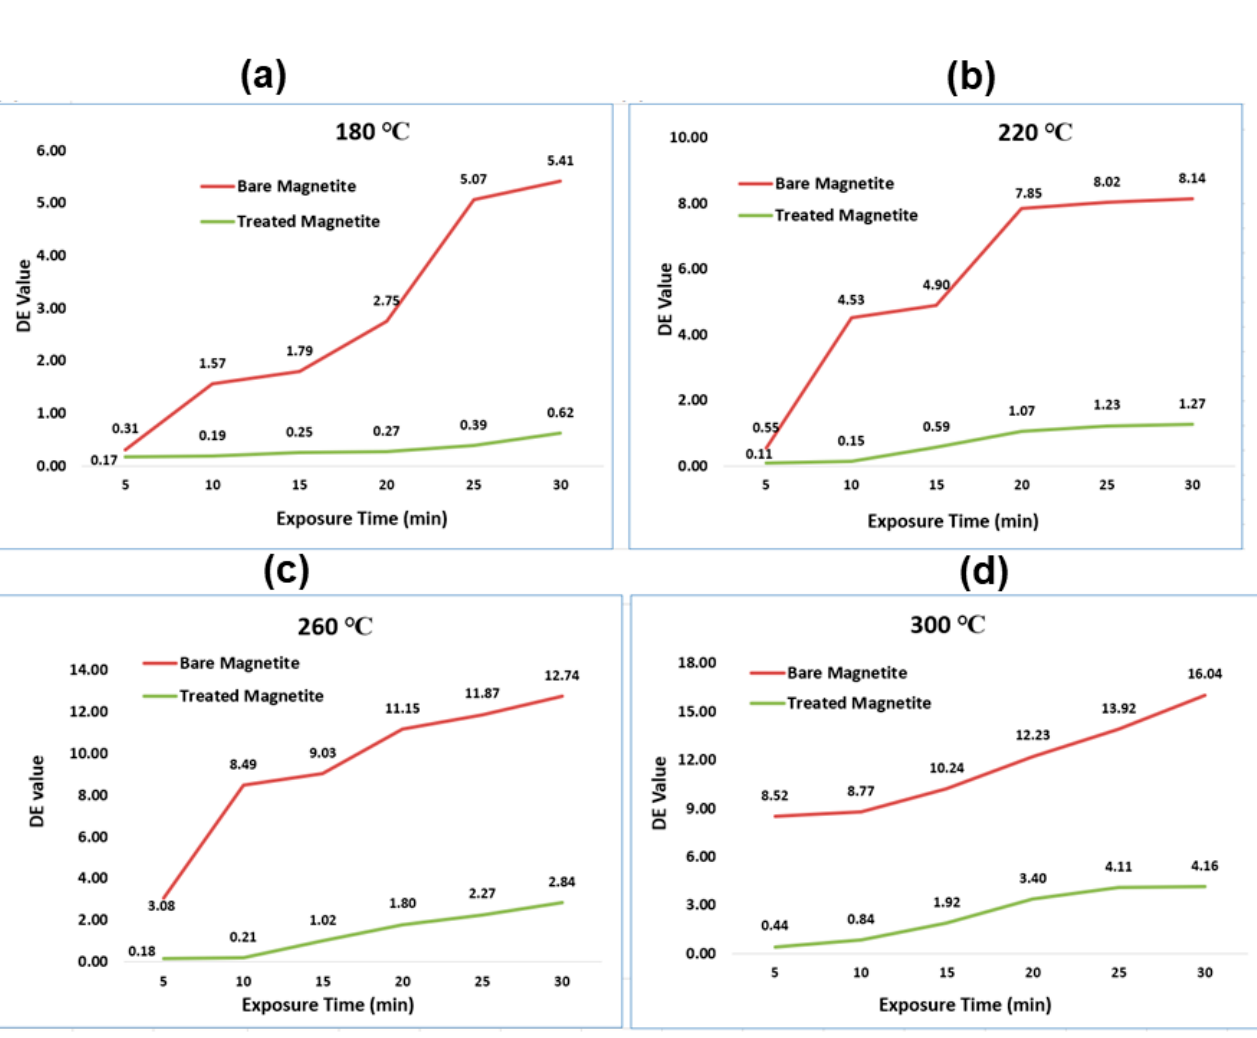
Figure 13. Plots depicting color difference delta-E (dE) values of bare and SHMP-treated Fe 3 O 4 samples calcined at ( a ) 180 ° C, ( b ) 220 ° C, ( c ) 260 ° C, and ( d ) 300 °C at different exposure times. 180 ◦ C, ( b ) 220 ◦ C, ( c ) 260 ◦ C, and ( d ) 300 ◦ C at different exposure